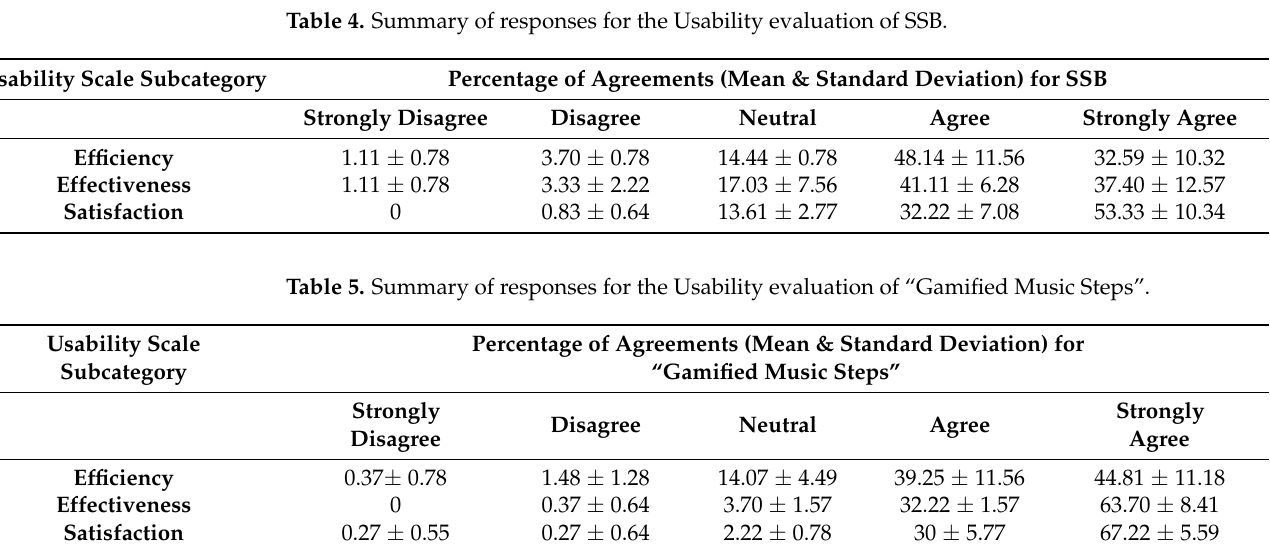
Table 4. Summary of responses for the Usability evaluation of SSB.